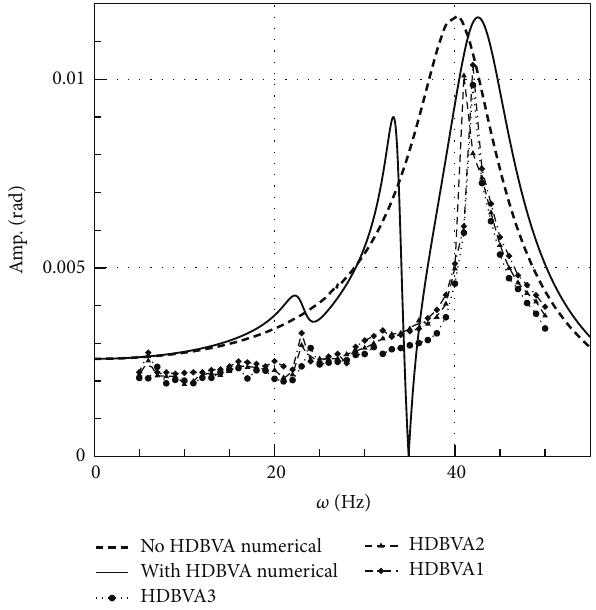
Figure 23: Frequency response of 𝑍 𝑍 DOF of case Figure 10(a), HDBVAs start at the far-from-force point.